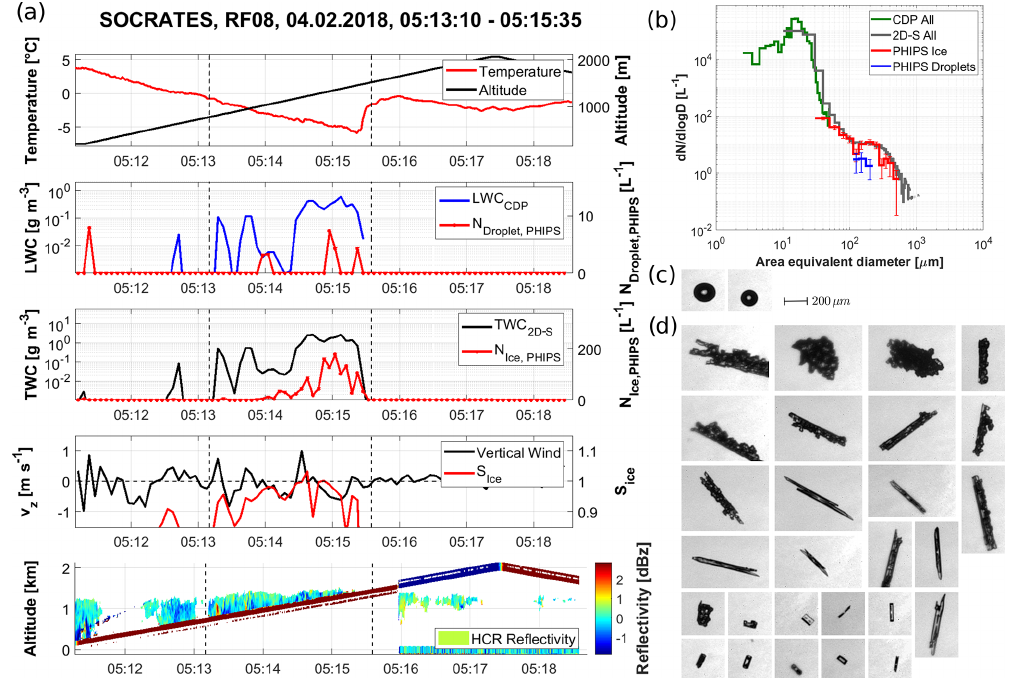
Figure 15. Same as in Figs. 13 and 14 but for a low-level mixed-phase cloud of SOCRATES research flight